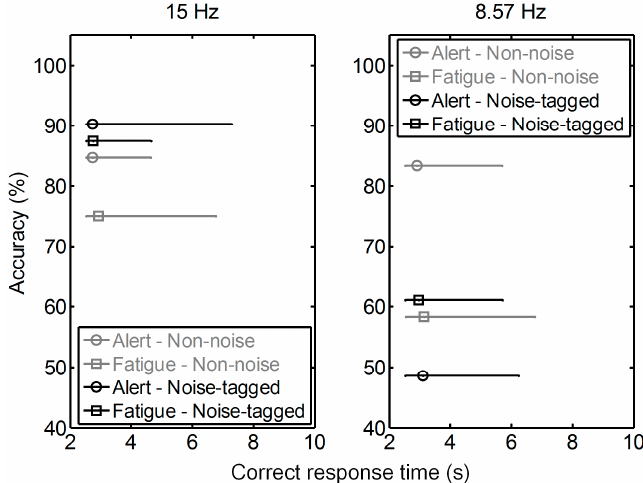
Figure 7. Online accuracy and correct response time in the alert versus fatigue state in both non-noise and noise-tagged BCI tasks across participants. The grand-averaged online accuracy and corresponding correct response time were calculated in semi-synchronous online BCI tasks performed across twelve participants. Results are shown in black for the noise-tagged task and in gray for the non-noise task. Each error bar characterizes the distribution of correct response time upon a certain online accuracy value, which was calculated as the grand-averaged percentage of correctly-judged trials. The upper and lower bounds of each error bar were set with maxima and minima of the time distribution, and the central point (circle and square) represents the mean. For convenience, the upper end of the ordinate was set above 100%.